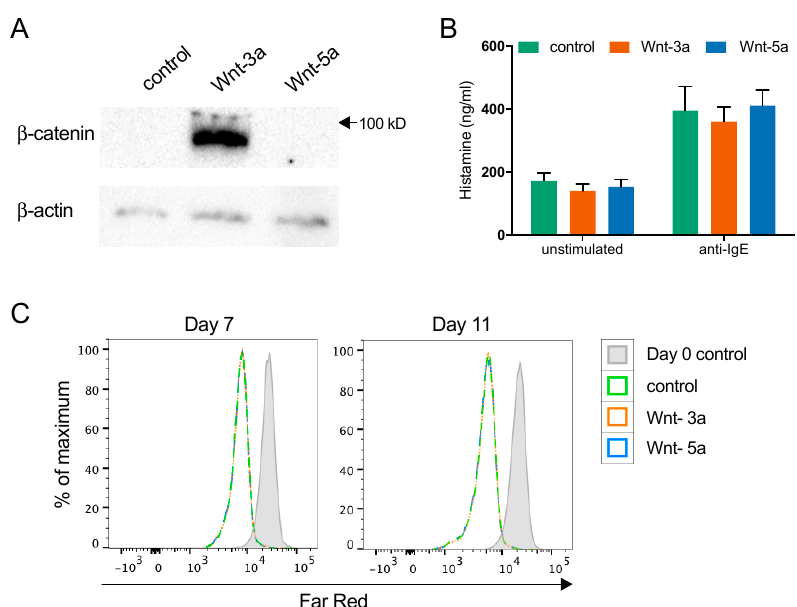
Figure 5. Wnt-3a activates the WNT/ β -catenin pathway in mature human mast cells. CBMCs were treated for 2 h with or without 300 ng/mL Wnt-3a or Wnt-5a, and Western blot analysis of β -catenin and β -actin was performed on the cell lysates ( A ). CBMCs were treated for 2 h with 300 ng/mL Wnts and thereafter activated with anti-IgE. The supernatant was collected after 30 min, and histamine release was measured; n = 6, means with SEMs ( B ). CBMCs were labeled with the cell proliferation dye CellTrace Far Red, cultured with or without 100 ng/mL Wnt-3a or Wnt-5a for 7 or 11 days and analyzed by flow cytometry. A representative histogram of three independent cultures for each of the different conditions is shown ( C ).